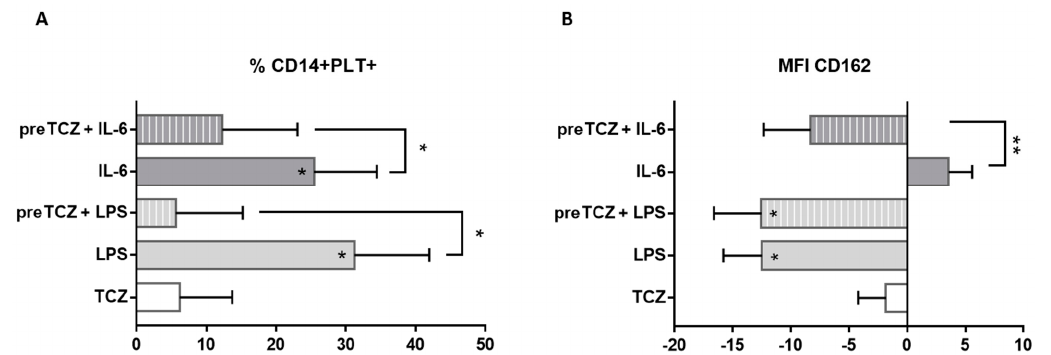
Figure 5. Effect of IL-6 and tocilizumab on platelet binding and CD162 expression on monocytes. Peripheral whole blood from healthy donors was cultured without stimulus or stimulated with lipopolysaccharide (LPS), recombinant human IL-6 or tocilizumab (TCZ). When TCZ stimulus is prior to LPS or IL-6 treatment is indicated as pre-. Differences between each condition and basal condition were calculated from 7 independent experiments. X axis represents percentage of increase or decrease from basal condition. Data are expressed as mean with standard error of mean. Stars inside the bars indicate comparison with basal condition. ( A ) Percentage of monocytes with bound platelets or ( B ) CD162 expression on monocytes was evaluated. Statistical analysis was performed using Wilcoxon test. * p < 0.05, ** p <